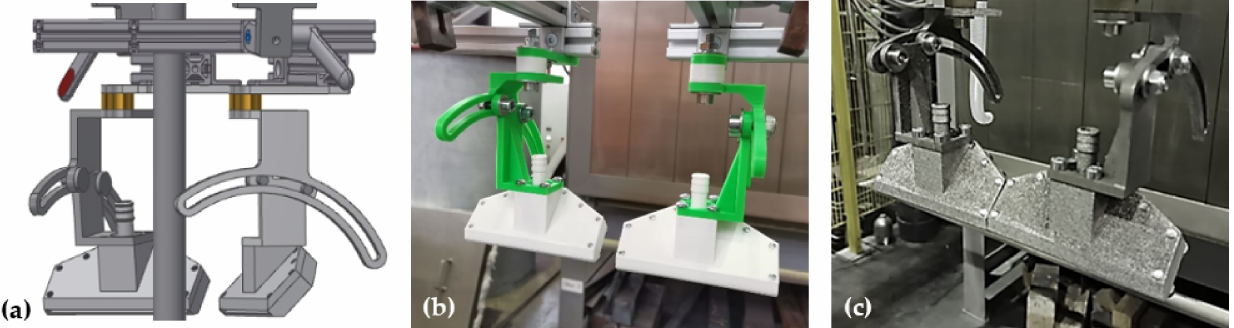
Figure 4. Construction sequence of the systems based on the gas-based skimming system: ( a ) Design; ( b ) 3D-printed plastic model; and ( c ) Additively manufactured metallic